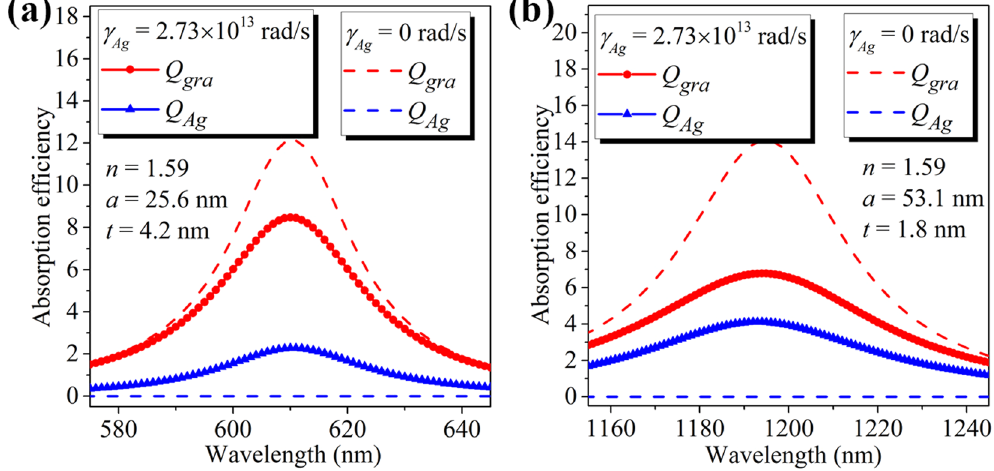
Figure 7. Graphene (red curves) and silver (blue curves) absorption efficiency spectra calculated for the graphene-wrapped DMCSRs with fixed core refractive index of n = 1.59 and the permittivity of silver being described by the lossless Drude model ( γ Ag = 0 rad/s, dashed lines) and the lossy Drude model ( γ Ag = 2.73 × 10 13 rad/s, solid symbols), in which the parameters are optimized so that the graphene absorption efficiency can reach its maximum value at the wavelength of λ = 610 nm ( a ) and the wavelength of λ = 1195 nm ( b